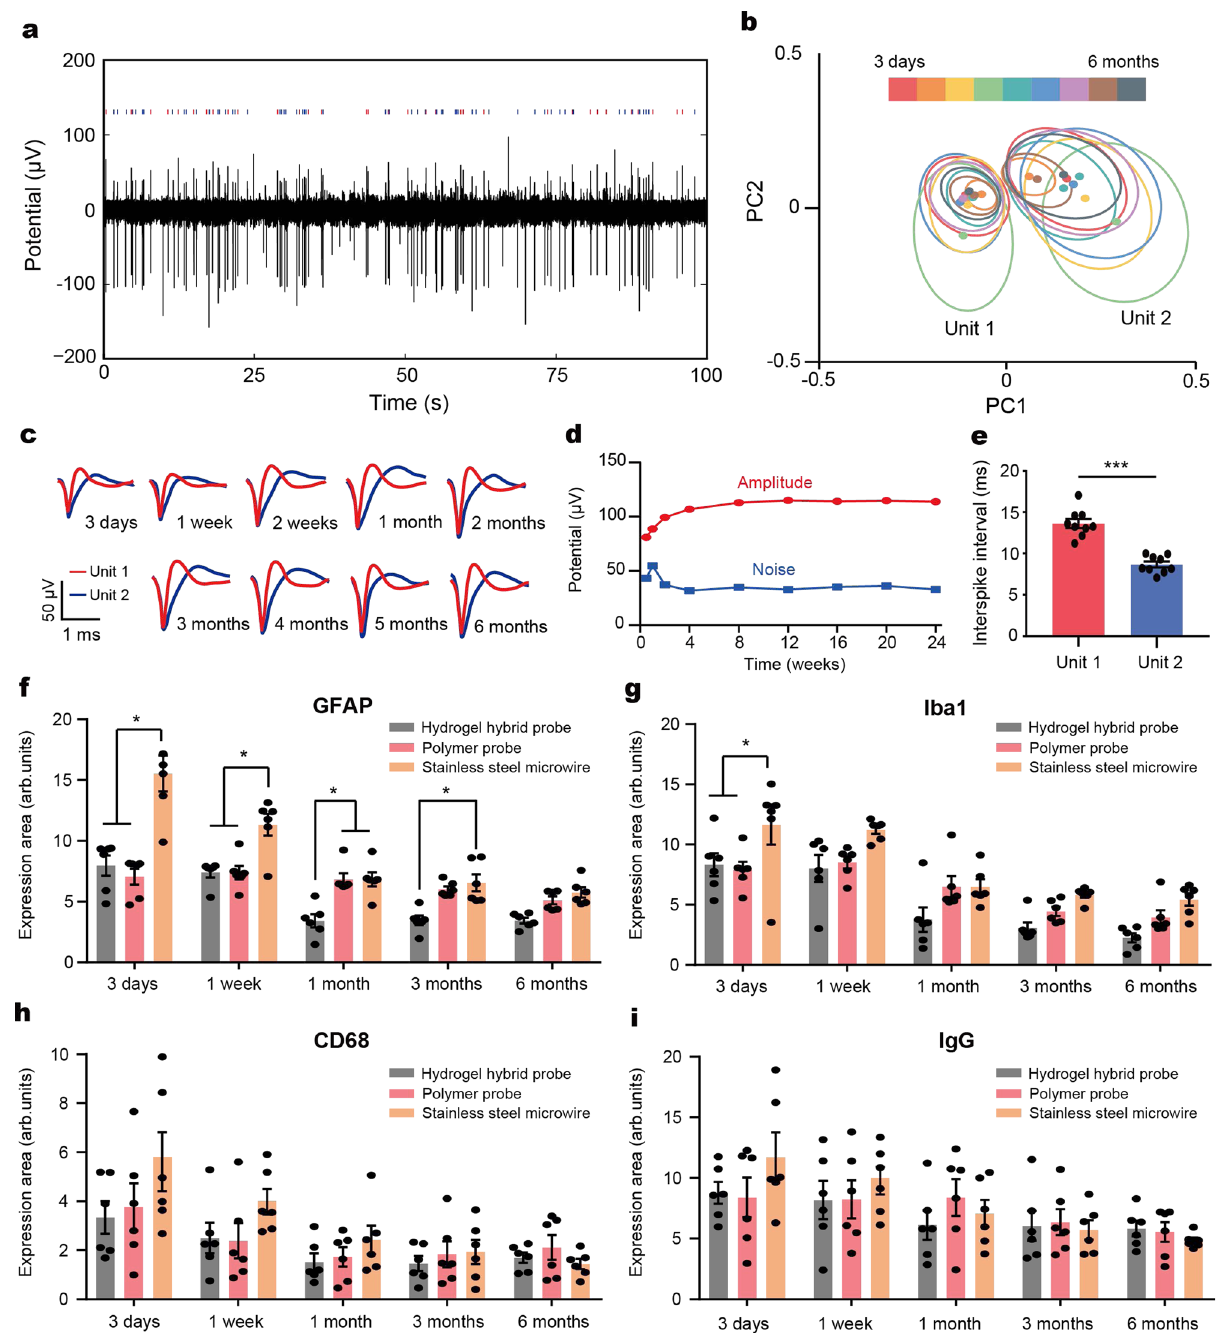
Fig. 4 Long-term investigation of single-unit potentials and foreign body responses. a Representative spontaneous electrophysiological activity recorded in the vHPC using a hydrogel hybrid probe 1 month following implantation. b Principle component analysis of the single-unit potentials (spikes) recorded 3 days, 1 week, 2 weeks, and 1 – 6 months following implantation. Closed circles indicate centers and ellipses represent two standard deviations (2 σ ) contours of the principle component distributions. c Average spike waveforms recorded over time corresponding to clusters in b . d Average